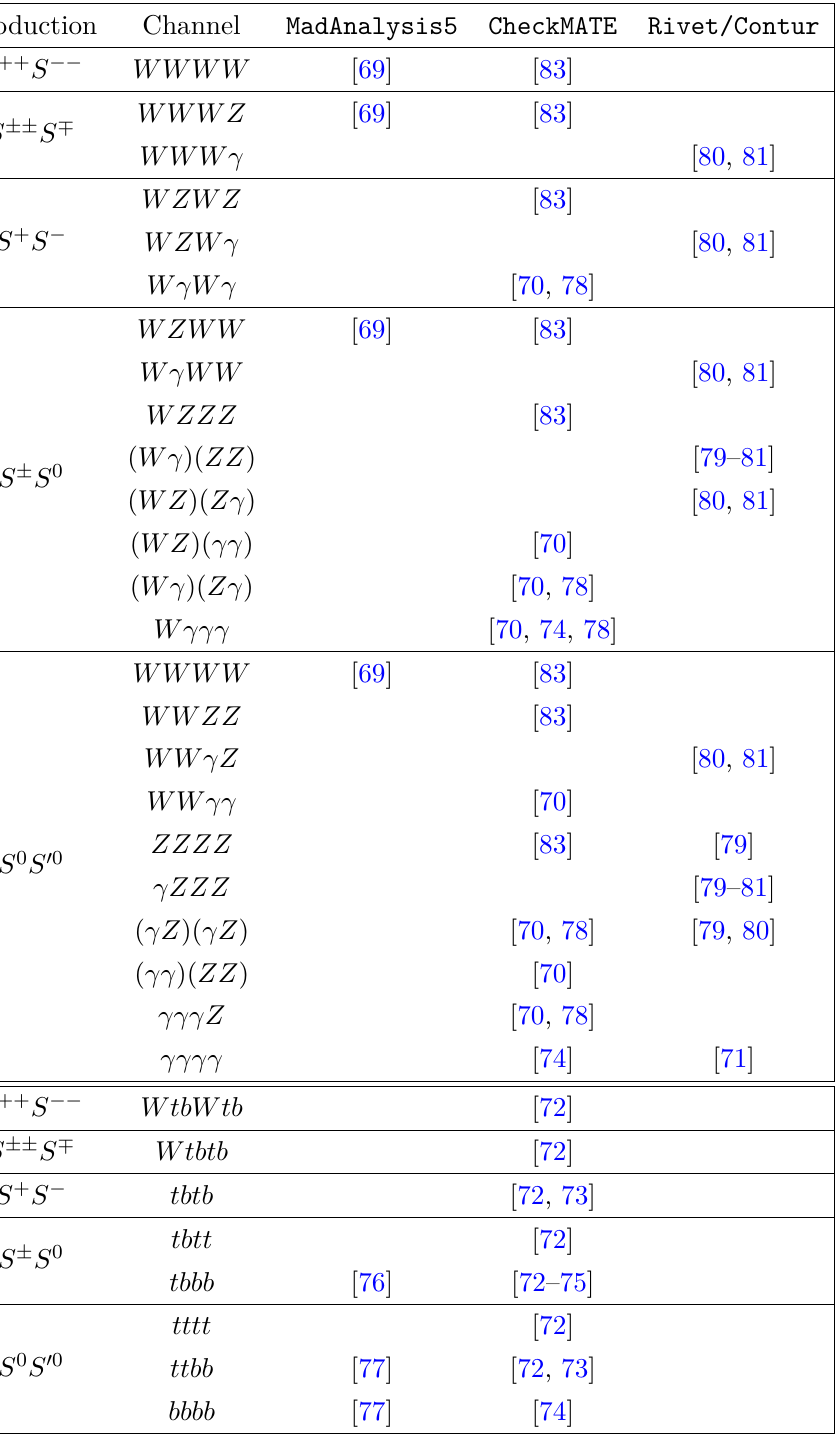
Table 4. Experimental analyses contributing to the simplified model bounds in figure 2. More details are available on